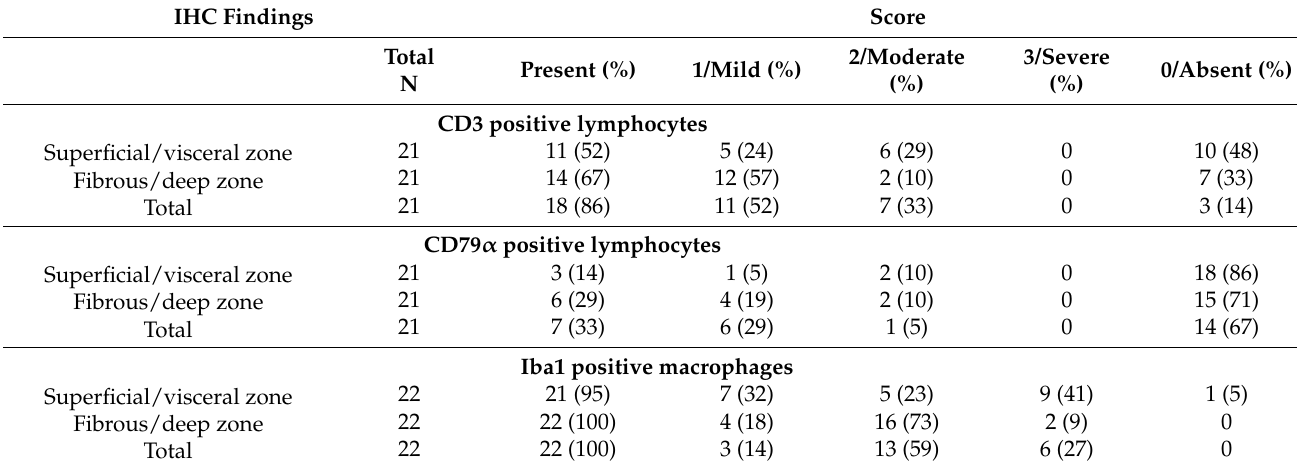
Table 4. Semiquantitative scoring of IHC findings in IPs.